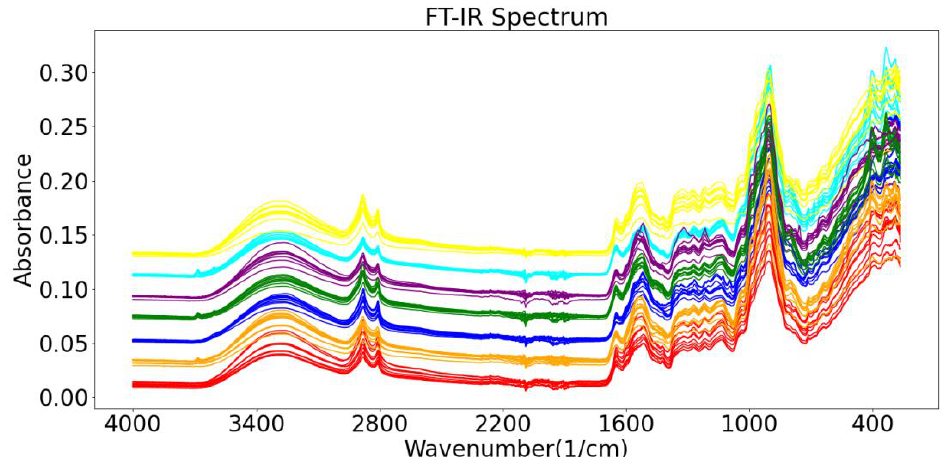
Figure 7. Raw FT-IR spectral data of wild Gentiana genus